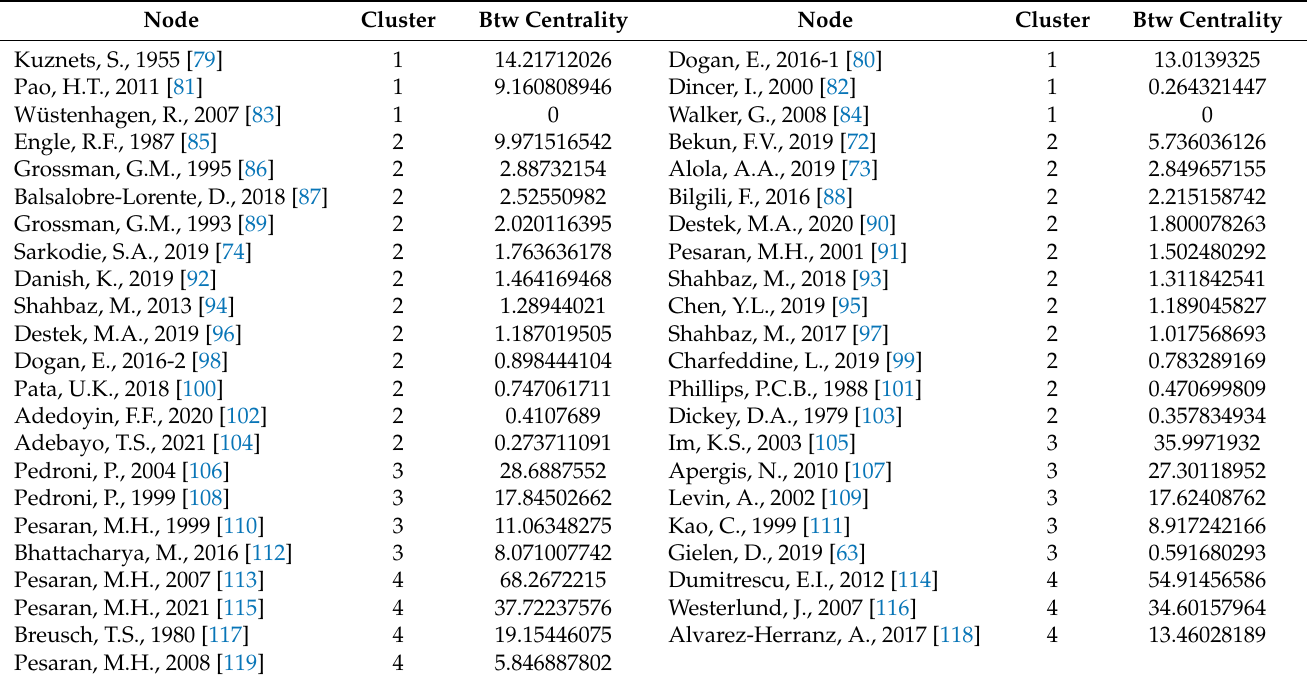
Table 11. Co-citation